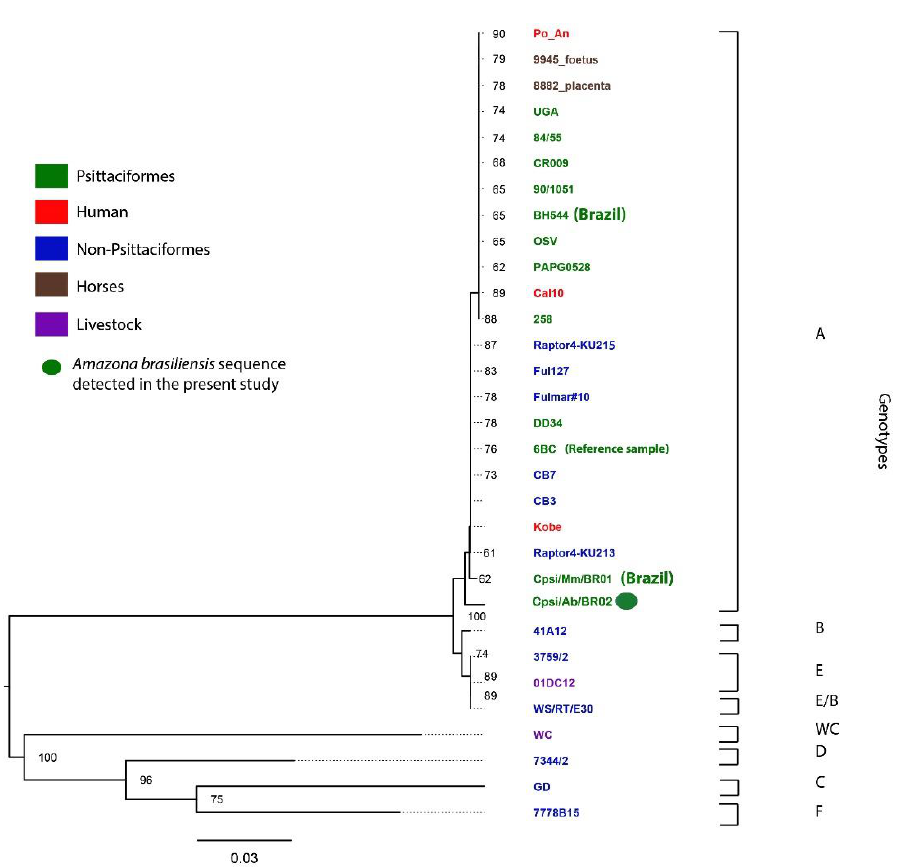
Figure 2. A mid-point rooted, neighbor joining phylogeny of the partial DNA sequences of the Chlamydia psittaci outer membrane protein gene alignment (1000 bootstrap replicates). Bootstrap support of nodes is shown if it exceeds 60%. (Cpsi/Ab/BR02, GenBank accession number MT741095).